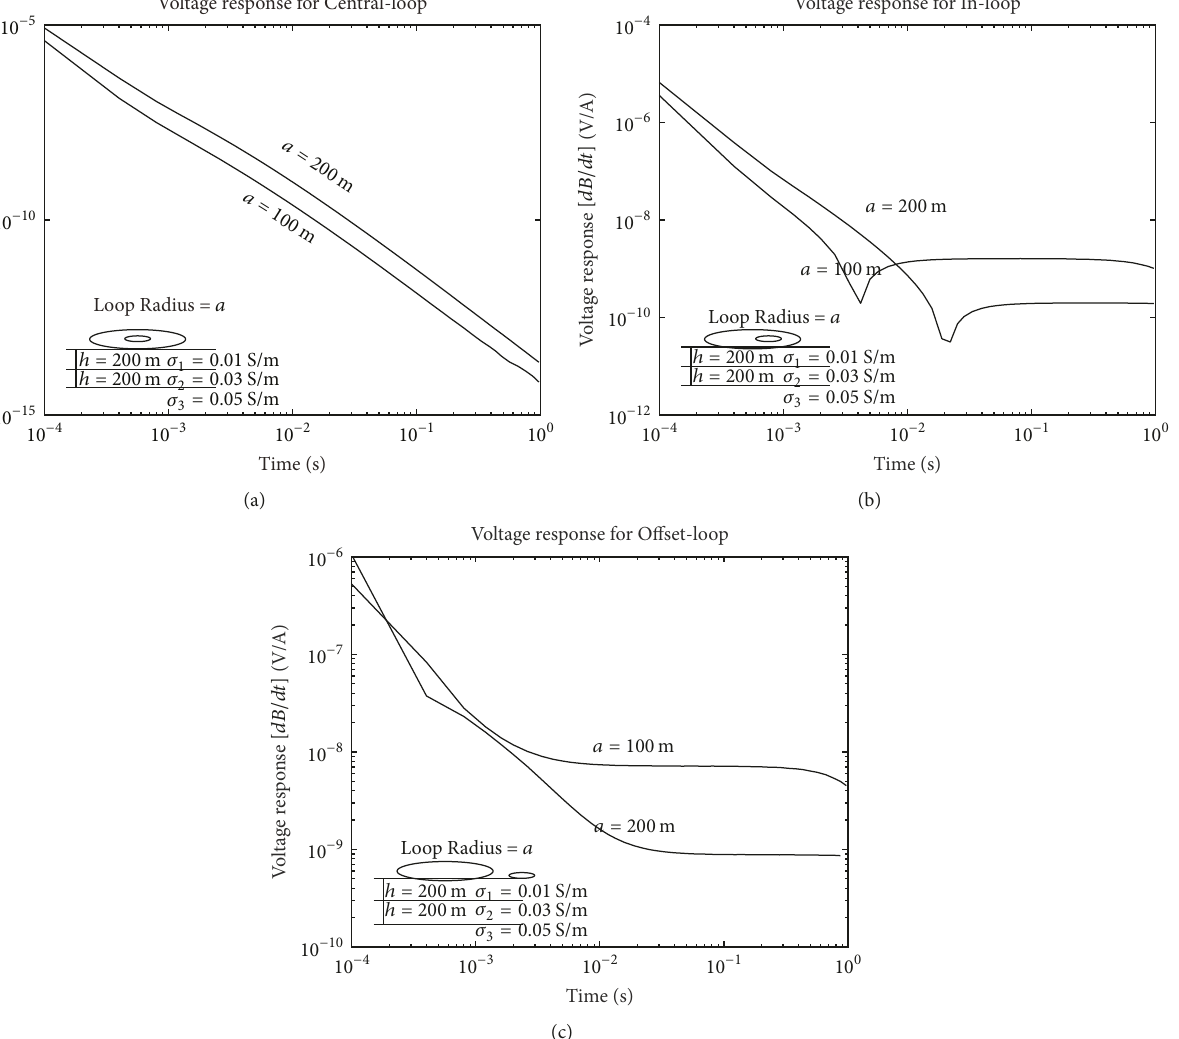
Figure 4: Transient voltage response of large circular loop source of radii 100 m and 200 m over the 3-layer earth model (as shown in the inset of the figure) for (a) central loop configuration, 𝑟 = 0 , (b) arbitrary in-loop configuration, 𝑟 = 𝑎/2 , and (c) arbitrary offset-loop configuration, 𝑟 = 2𝑎